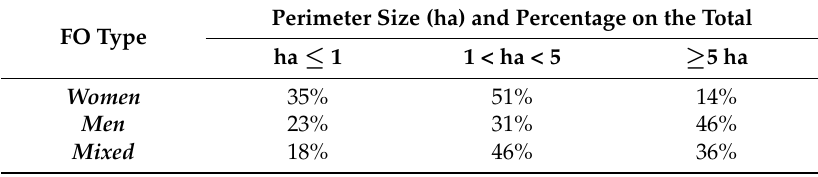
Table 6. Average perimeter size of each type of